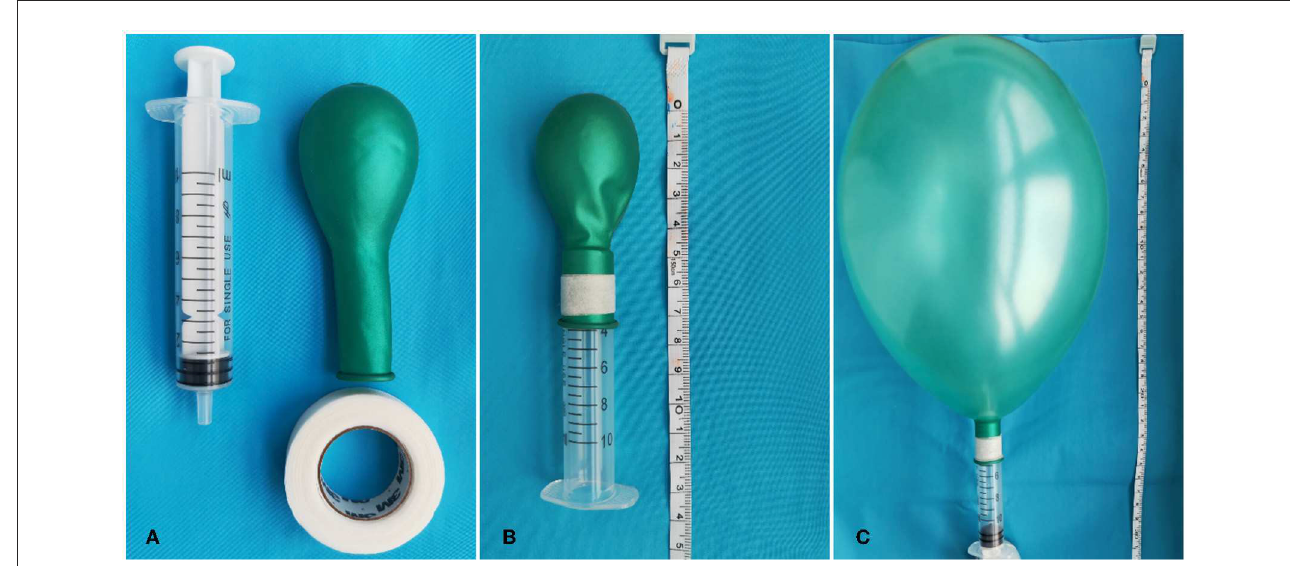
FIGURE1 Production of the MVM device. (A) Materials: 10ml syringe (Hongda Medical Equipment Group Co., Ltd., Jiangxi, China), one medium-size balloon (Piao Fa Industrial Co., Ltd., Shenzhen, China), and leucoplast [Minnesota Mining Manufacturing Medical Equipment (Shanghai) Co., Ltd.]. (B) The balloon is circled around the syringe and fixed by leucoplast. (C) After blowing into the syringe, the balloon will be in full tension. We defined this procedure as an effective Valsalva